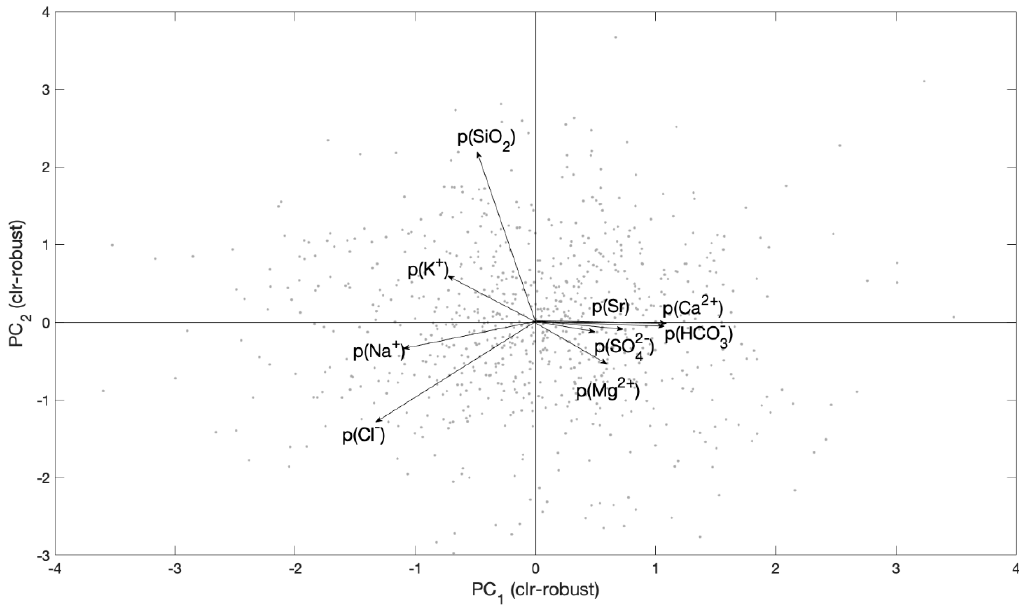
Figure 3. Biplot of the first and second components obtained through a robust principal component analysis applied to the perturbation-subtraction matrix.